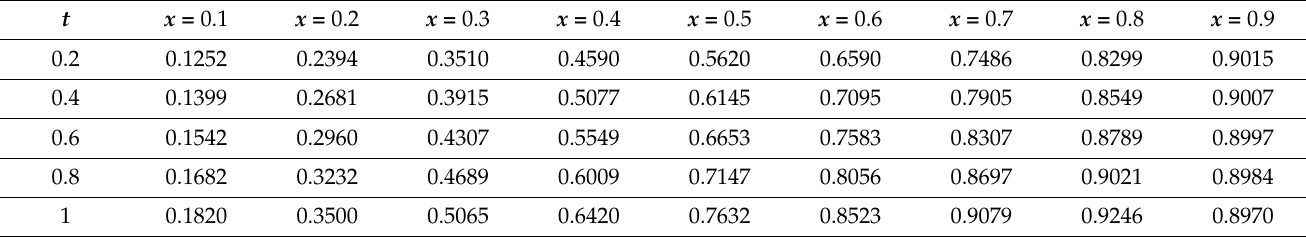
Table 1. Numerical values of moisture content U ( x , t )